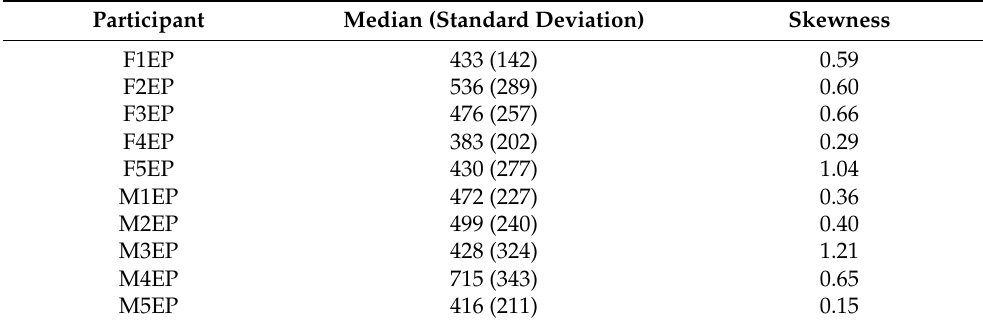
Table 3. Median (and standard deviation) in ms, and Pearson skewness of pause duration for the Portuguese participants of the Current Set.